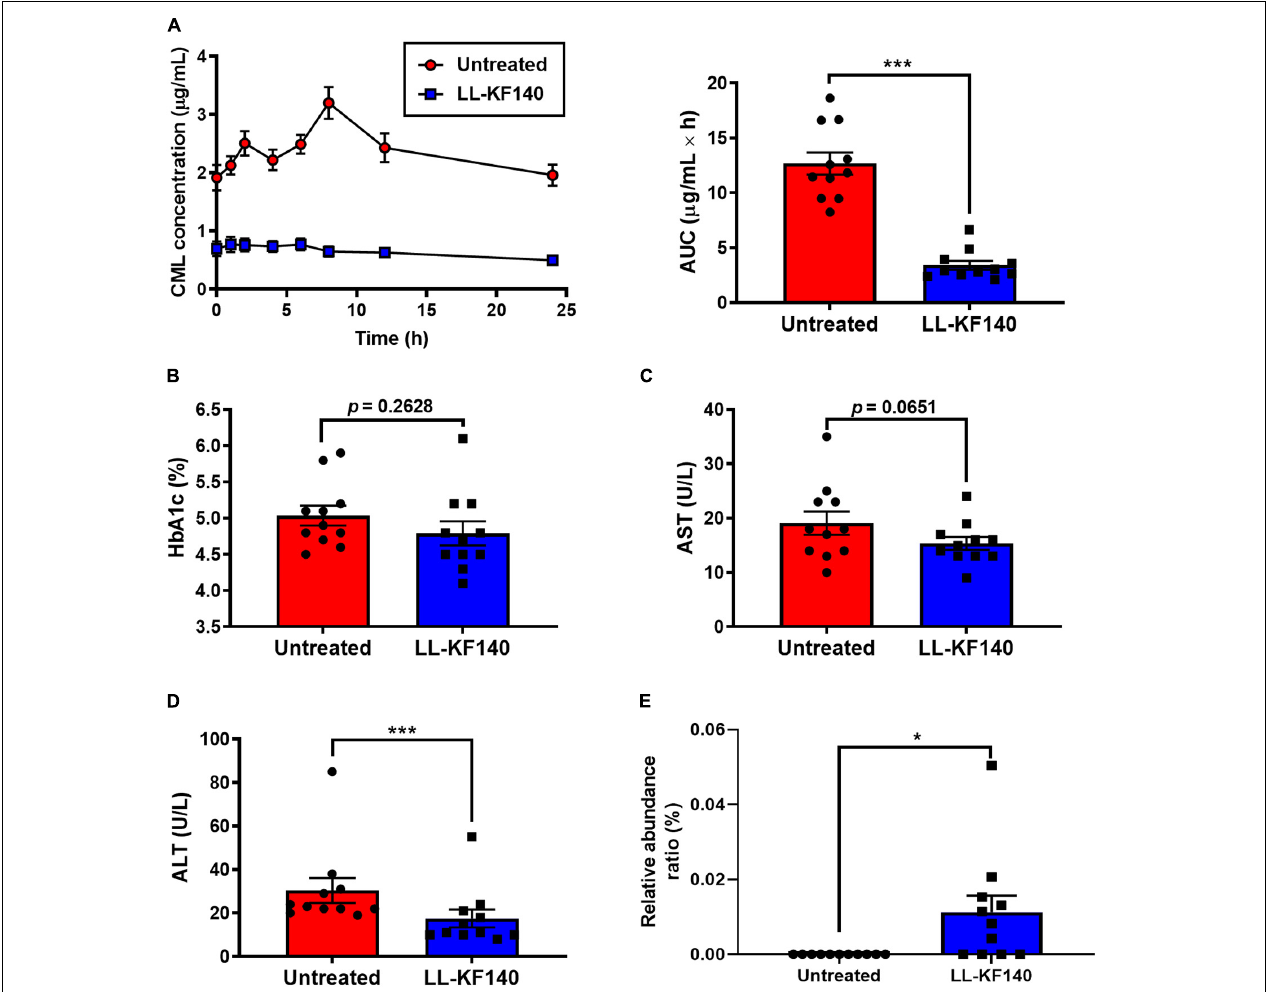
FIGURE 3 | Effect of ingesting Lactococcus lactis KF140 (LL-KF140) on serum levels of N ε -(Carboxymethyl)lysine (CML) in human subjects. (A) Serum CML levels after intake of a CML-enriched parmesan cheese, before and 26 days after LL-KF140 administration. Serum concentrations of (B) HbA1c, (C) AST, and (D) ALT. (E) Relative abundances of L. lactis in stool samples of human subjects before and after LL-KF140 administration. Data are presented as the mean ± SEM ( n = 11). * p < 0.05, *** p < 0.001 (paired two-tailed Student’s t